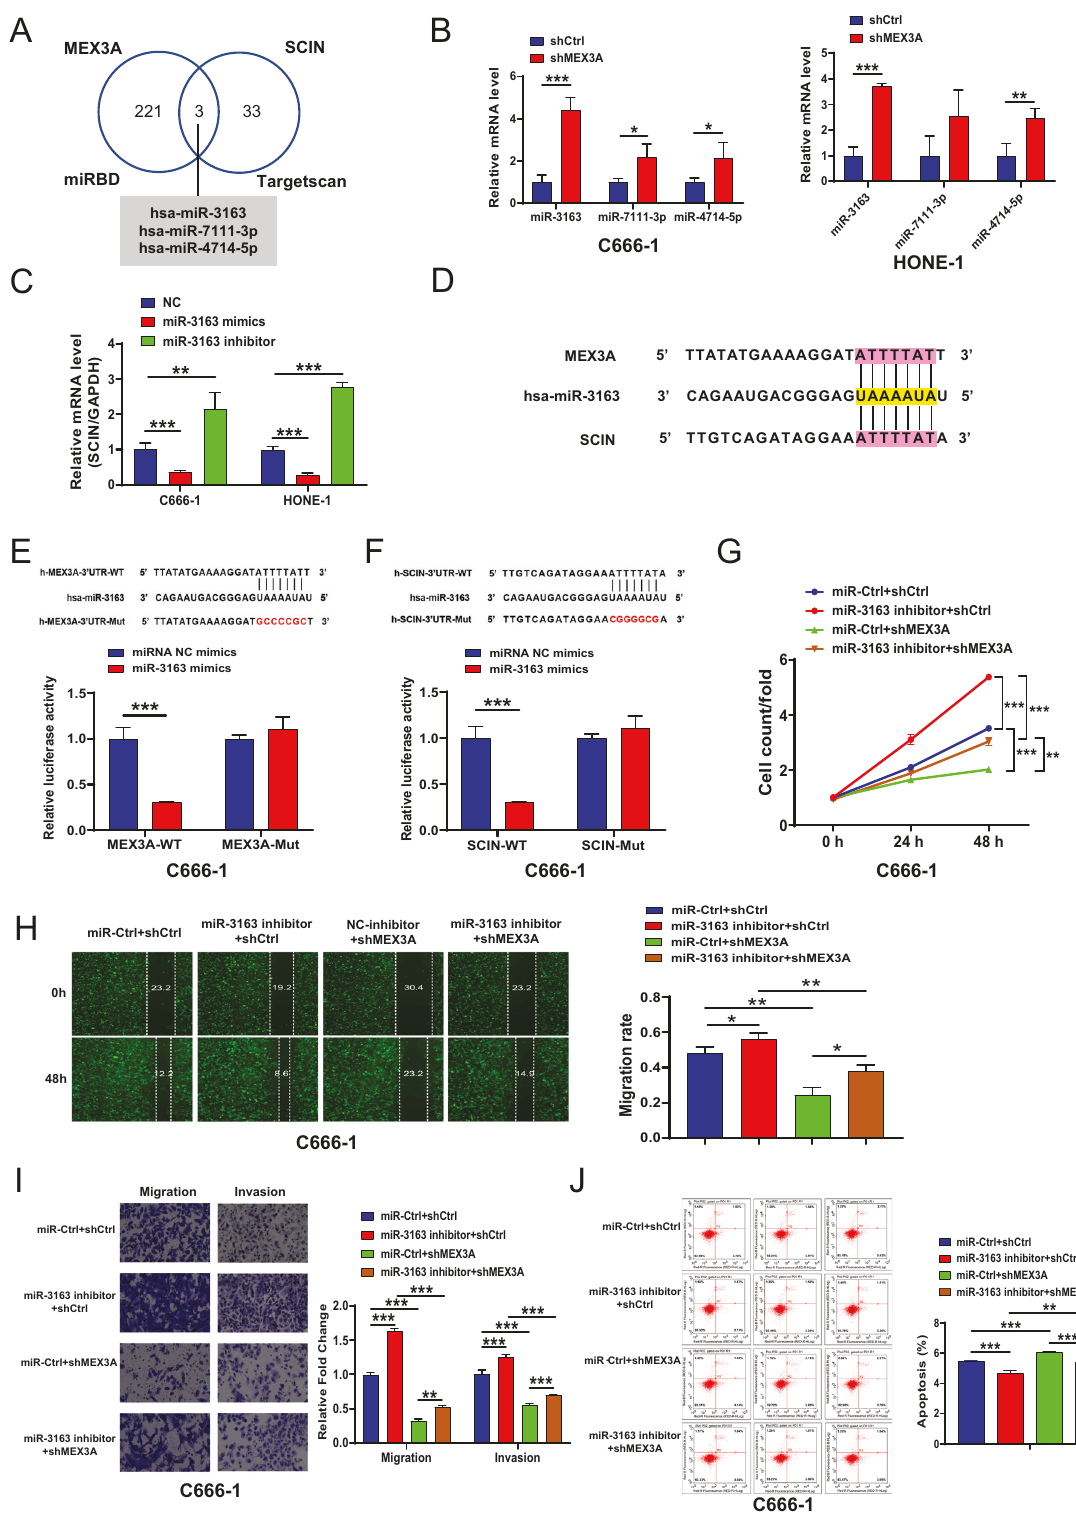
growth. Indeed, xenograft tumor volumes and weights were signi fi cantly lower in the shMEX3A group than in the shCtrl group ( P < 0.001, Fig. 3B and S2). Furthermore, H&E (Fig. 3C) and Ki-67 immunohistochemical (Fig. 3D) staining revealed reduced proliferative activity upon MEX3A depletion.